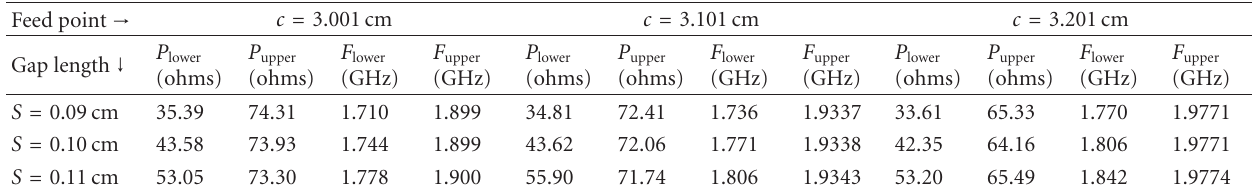
∗ P lower : The peak value of input impedance for lower band. ∗∗ P upper : The peak value of input impedance for lower band. # F lower : The resonance frequency for lower band. ## F upper : The resonance frequency for upper band. Table 3: Peak value of input impedance, resonance frequency for upper and lower band for di ff erent gap lengths. Feed point → c = 3.001 cm c = 3.101 cm Gap length ↓